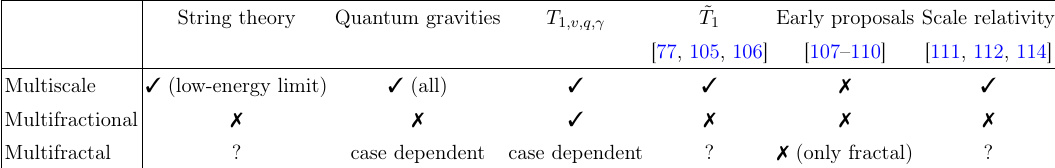
Table 2 . Multiscale, multifractional, and (multi)fractal theories and